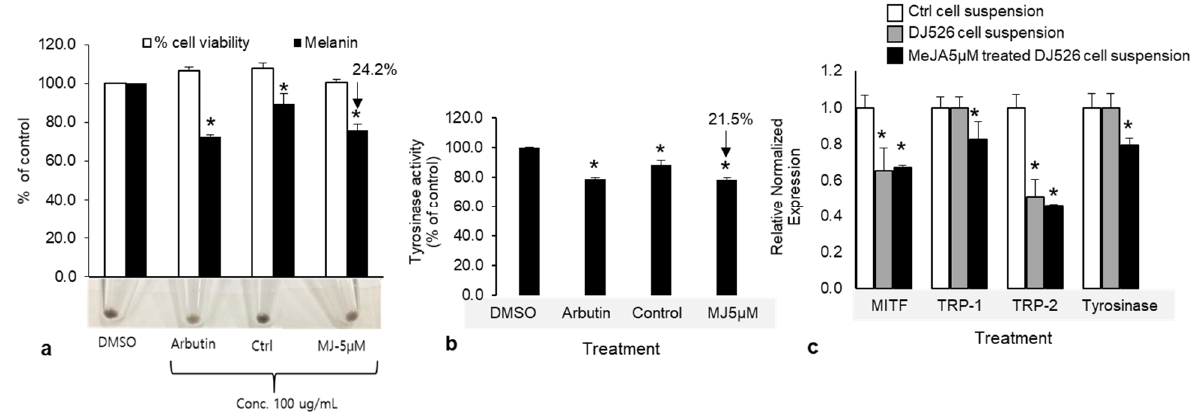
Figure 8. ( a ) Effects of methyl jasmonate (MeJA)-treated cell suspension extracts on melanin production and viability in melan-a cells. Cells (8 × 10 4 ) were treated with 100 mg mL − 1 of cell suspension extract and arbutin (positive control) for 3 days. ( b ) Intracellular tyrosinase activity of 5 µ M MeJA-treated and untreated cell suspension. Cell viability, melanin content, and tyrosinase activity are presented as percentages of the control (DMSO). Arbutin was used as a positive control. Data are presented as means ± SD of three independent experiments. * p < 0.05. ( c ) The expressions of melanogenic related genes, MITF , TRP-1 , TRP-2 , and tyrosinase, in MeJA-treated cell suspension and DJ526 cell suspension (treatment control).